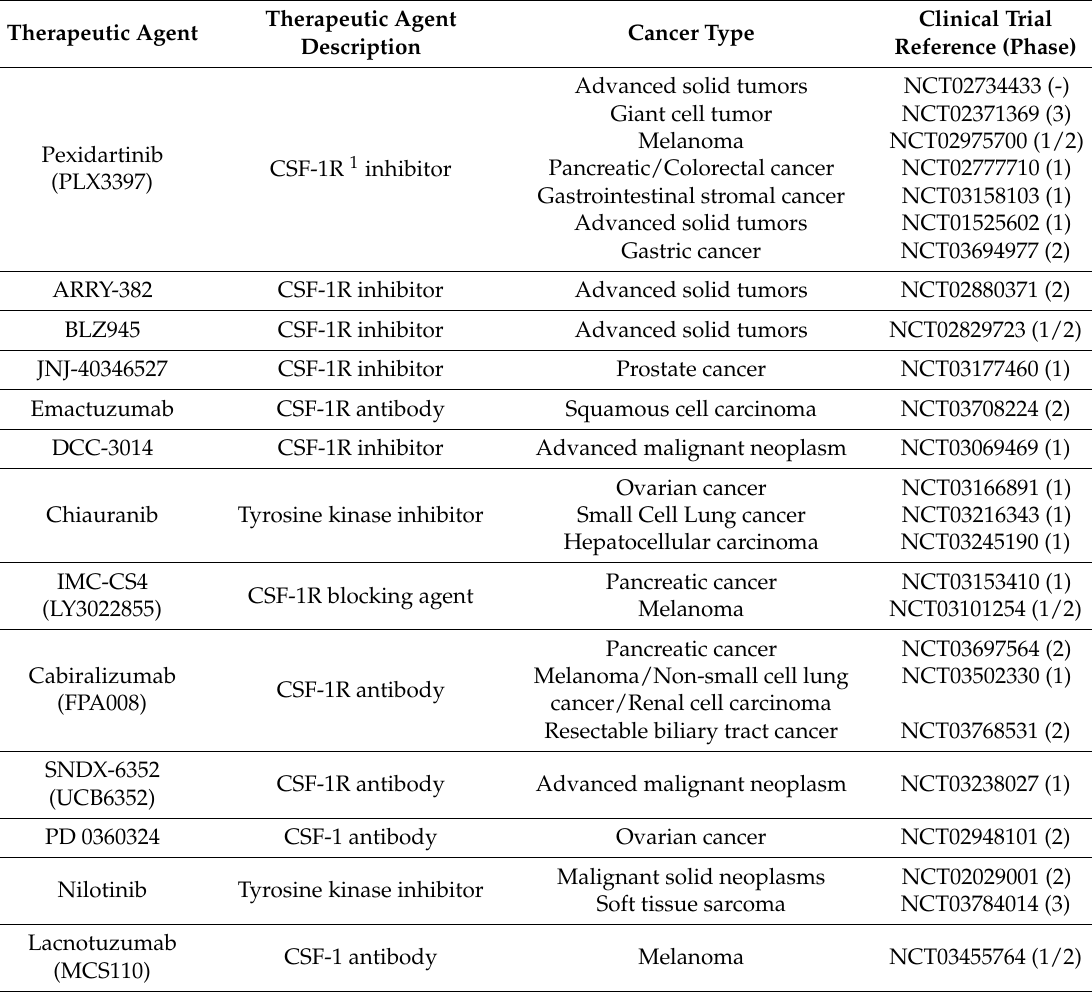
Table 2. Therapeutic agents targeting macrophages and myeloid-derived suppressive cells recruitment in interventional clinical trials currently recruiting or not yet recruiting. Data acquired from the U.S. National library of medicine (http://clinicaltrials.gov, accessed on 16 January